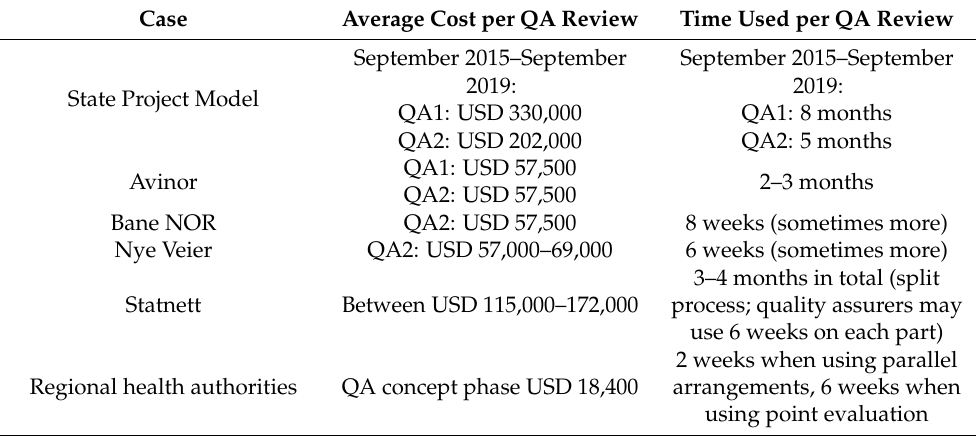
Table 5. QA costs and time used in the studied different